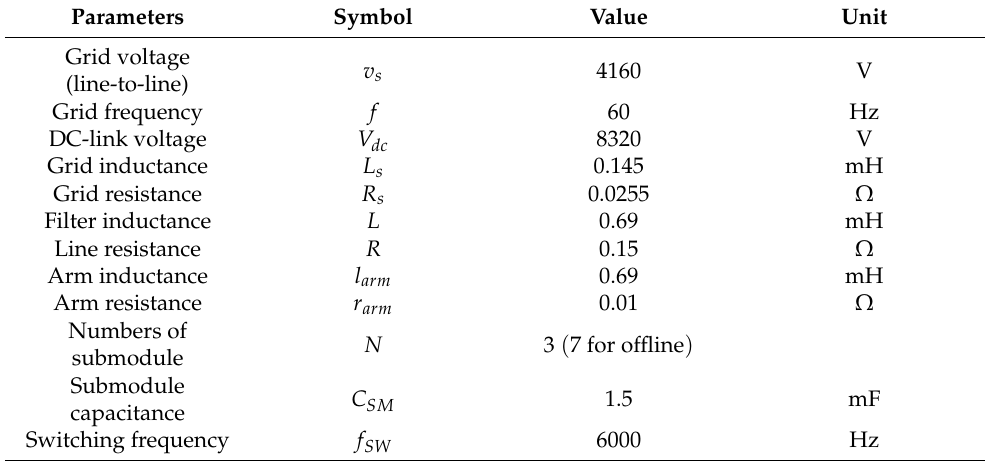
Table 1. MMC and grid